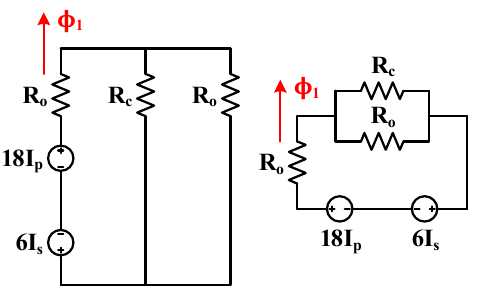
Figure 6. Equivalent reluctance model for flux split flow.